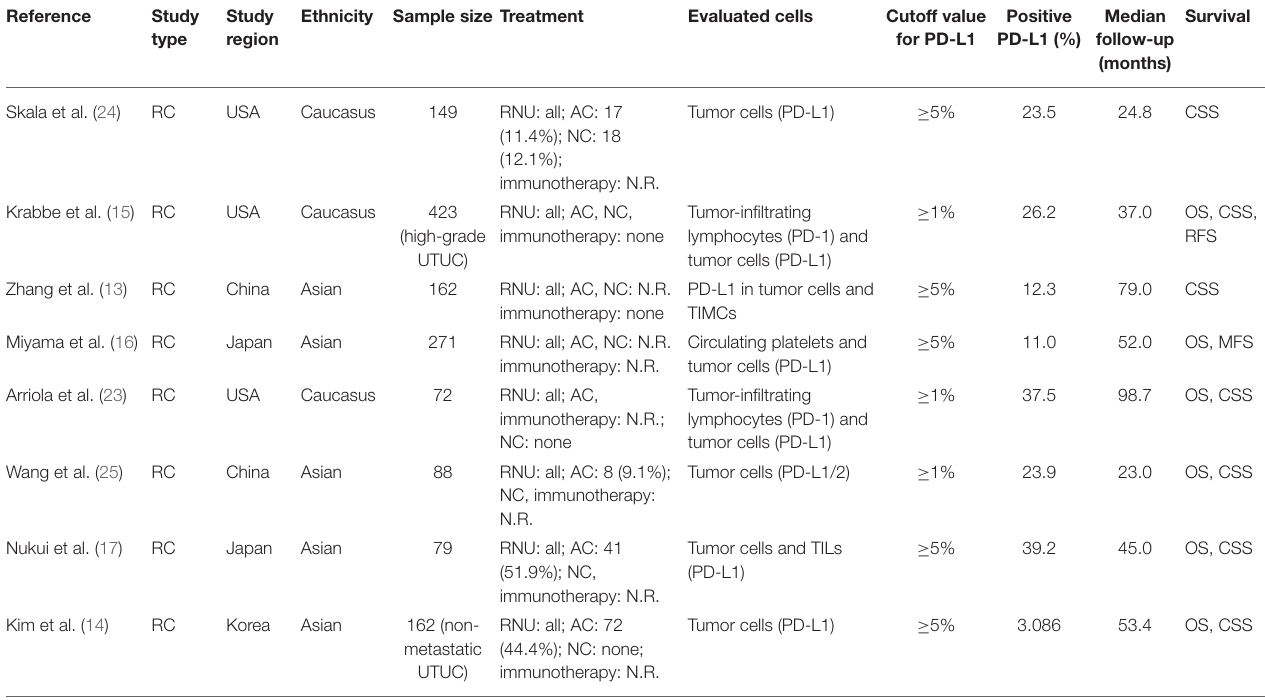
TABLE 1 | Characteristics of included